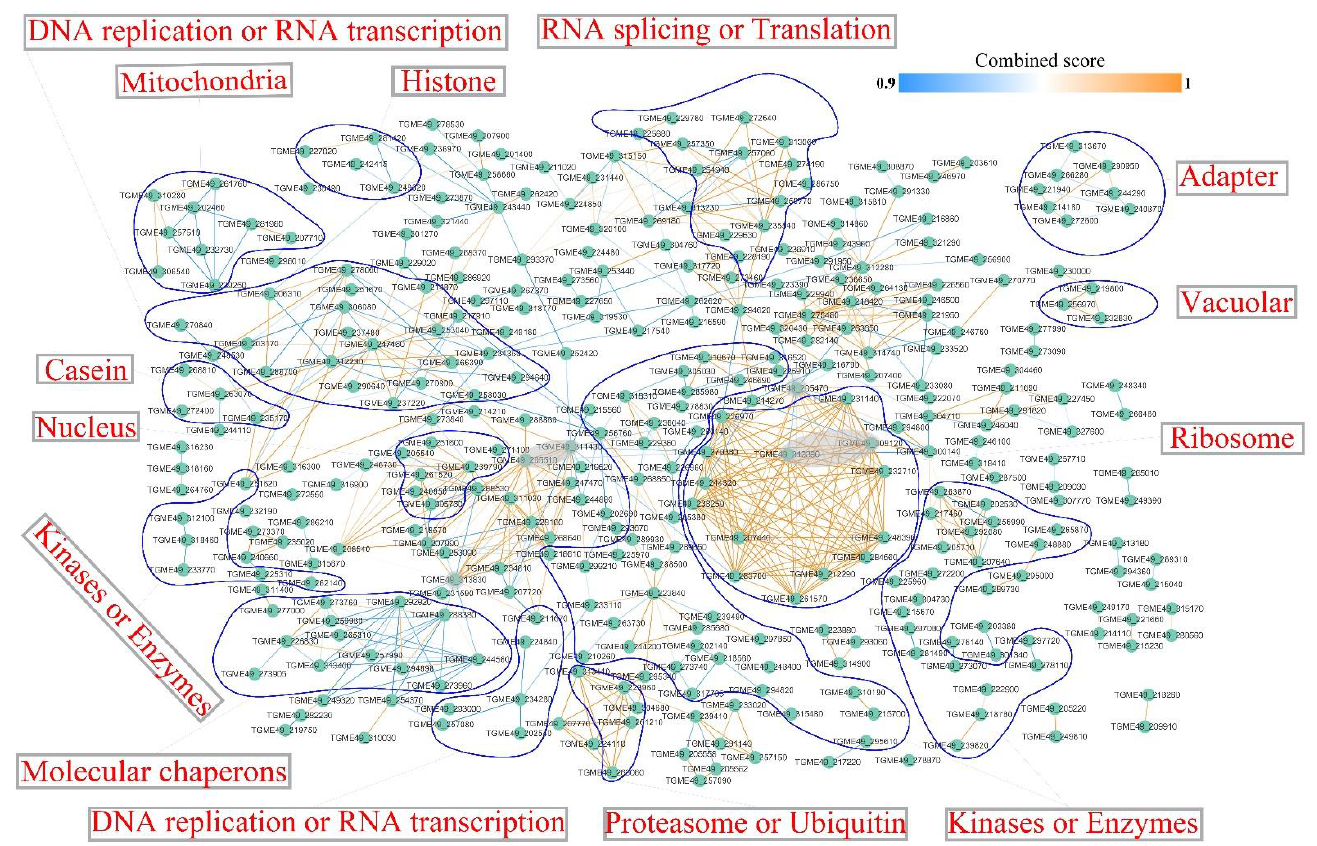
Figure 8. KEGG pathway enrichment analysis of DEPs between sporulated oocysts and tachyzoites. The y -axis indicates the KEGG pathways DEPs significantly enriched and the x -axis denotes the rich factors of the pathways. Rich factor implies the proportion of DEPs among total phosphoproteins in the pathway. Greater degrees of enrichment are indicated by higher rich factors. The color and size of the node represent the p value and quantity of phosphoproteins of the corresponding pathways.